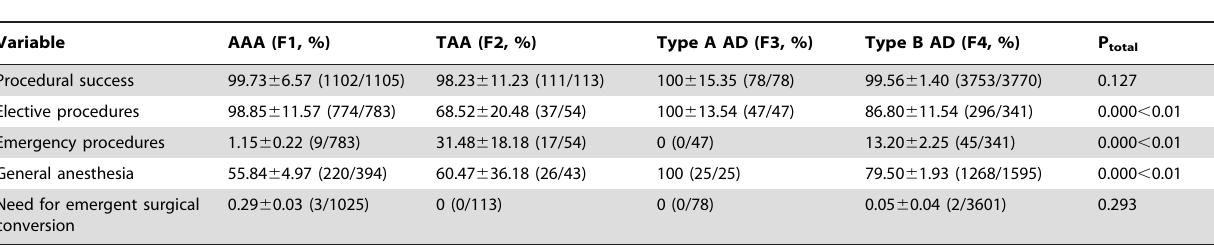
Table 2. Procedural data of patients with aortic diseases.